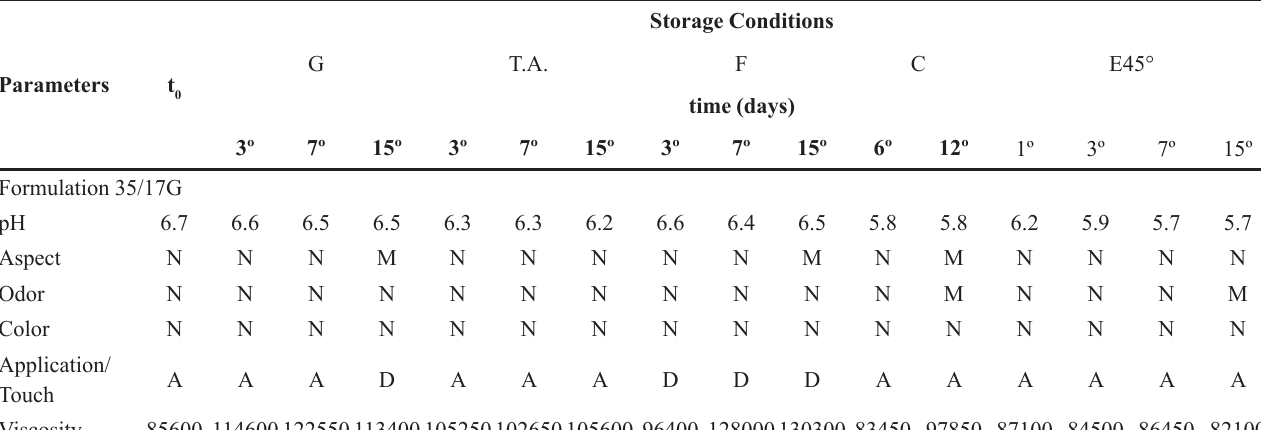
TABELE IV - Evaluation of the organoleptic characteristics, pH and apparent viscosity of formulation F35/17G , in the Accelerated Stability Study